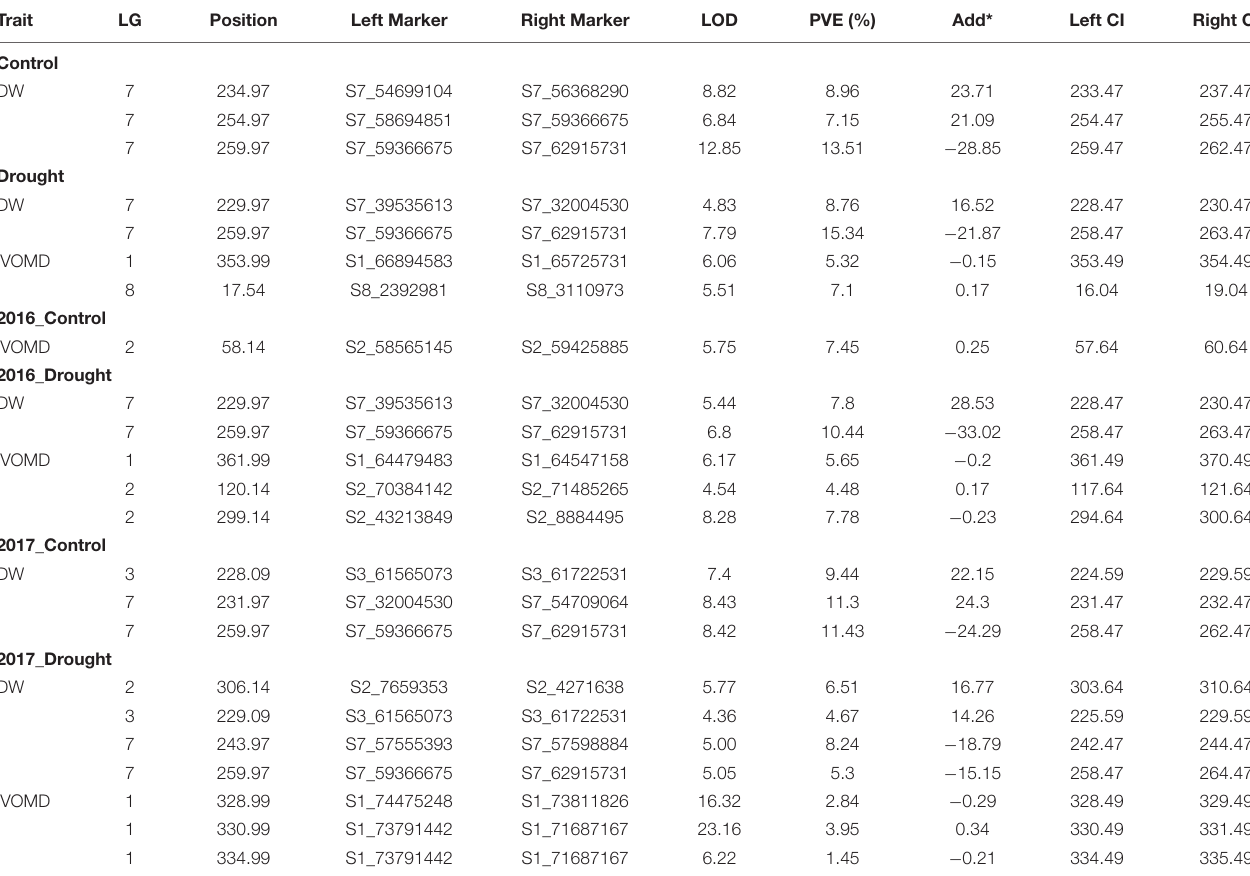
TABLE 5 | Quantitative trait loci detected for dry weight (DW) and digestibility (IVOMD) in ICSV1 × ICSV700 RIL population. Trait LG Position Left Marker Right Marker LOD PVE (%) Add* Left CI Right CI